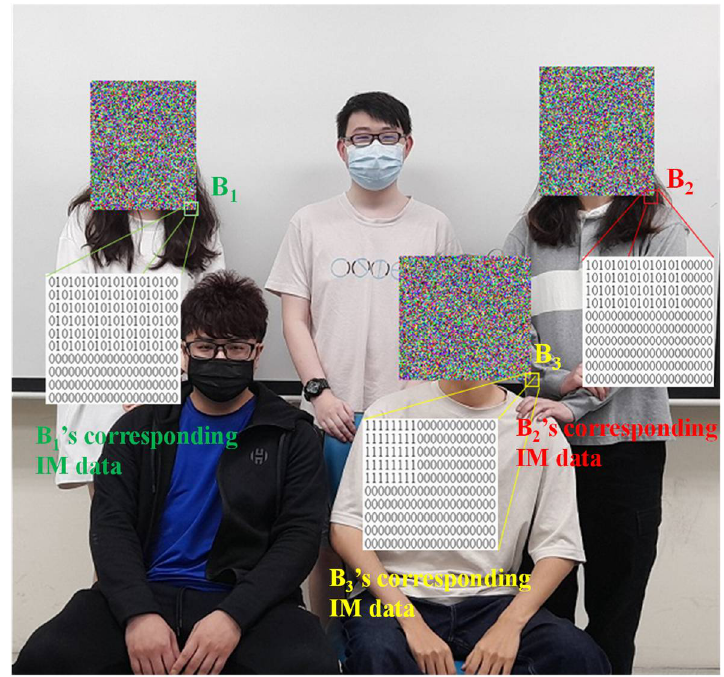
Figure 9. The image map for three authorized